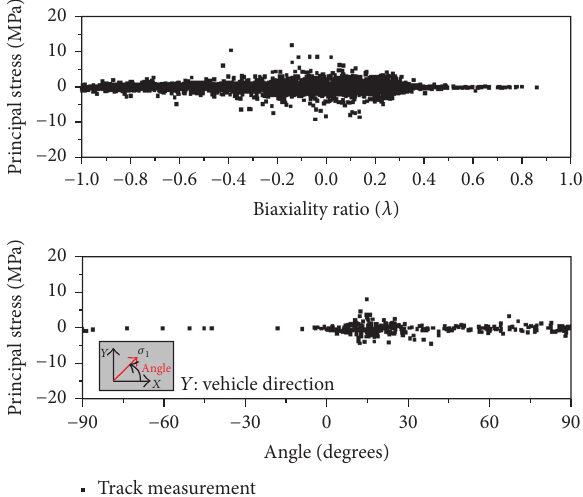
Figure 13: Changes in principal stress in fatigue test (Point 1).